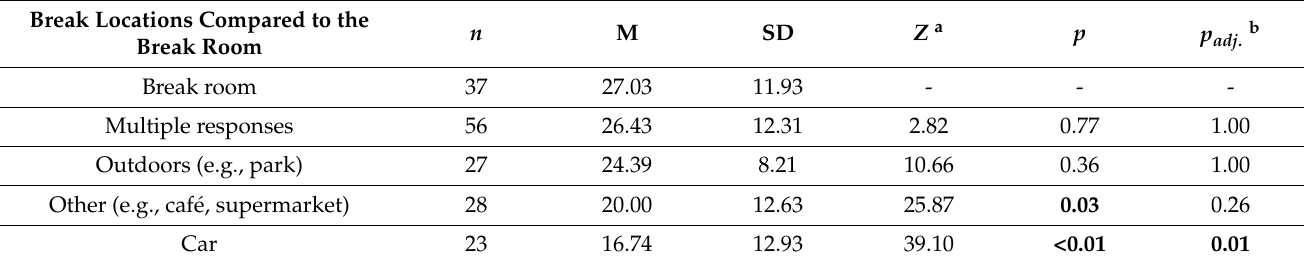
Table 2. Length of breaks spent at the different break locations as compared with in a break room.